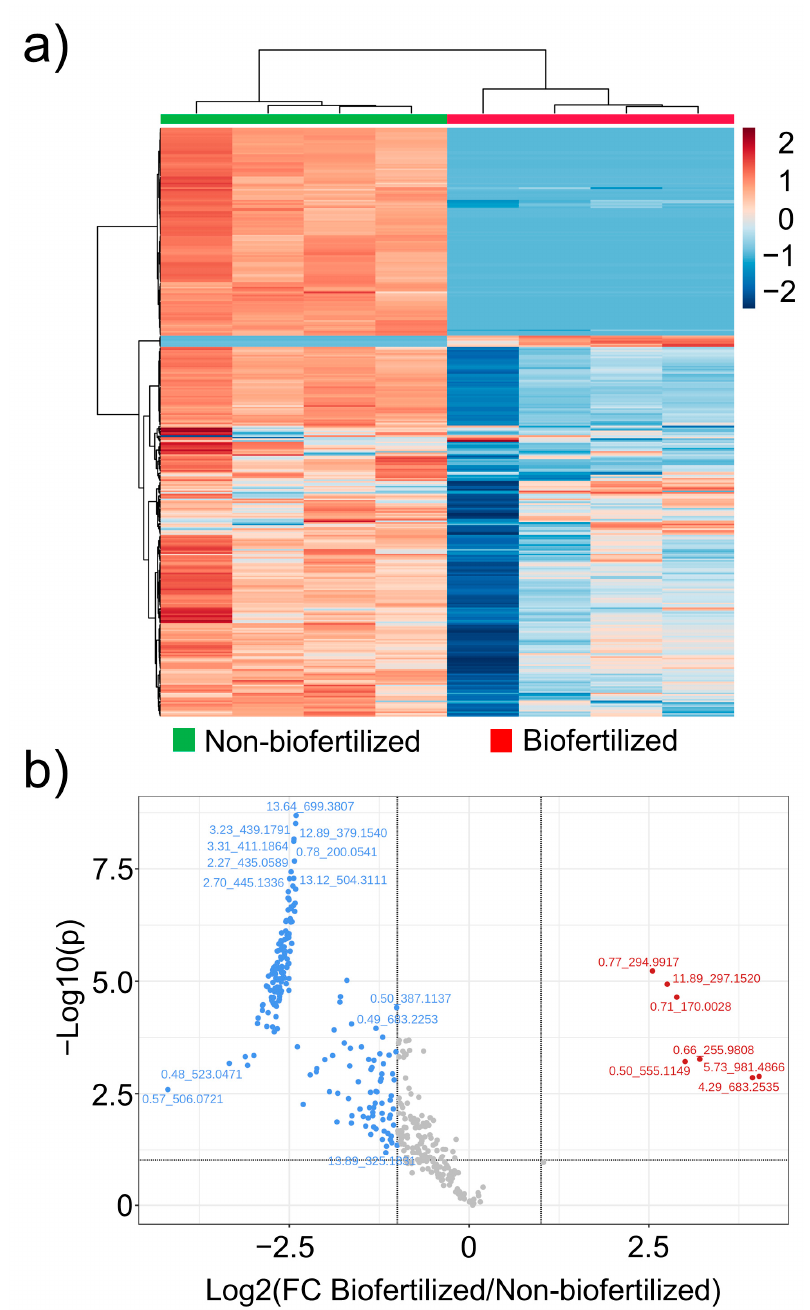
Figure 3. ( a ) Heatmap of biofertilized (KB75) and non-biofertilized (KF75) samples analyzed in ESI-mode in the evaluation of the biofertilizing effect of Acinetobacter calcoaceticus UTMR2 in tomatillo fruits ( Physalis ixocarpa Brot cv. “cáscara morada”) at 75% of the recommended potassium dose [20]. At the top is shown the hierarchical clustering using the algorithm of Ward and the Euclidean distance. ( b ) Volcano plot representing the results of the fold-change analysis. Both figures were obtained using the MetaboAnalyst bioinformatic platform (https://www.metaboanalyst.ca/MetaboAnalyst/home.xhtml, accessed on 7 September 2022).